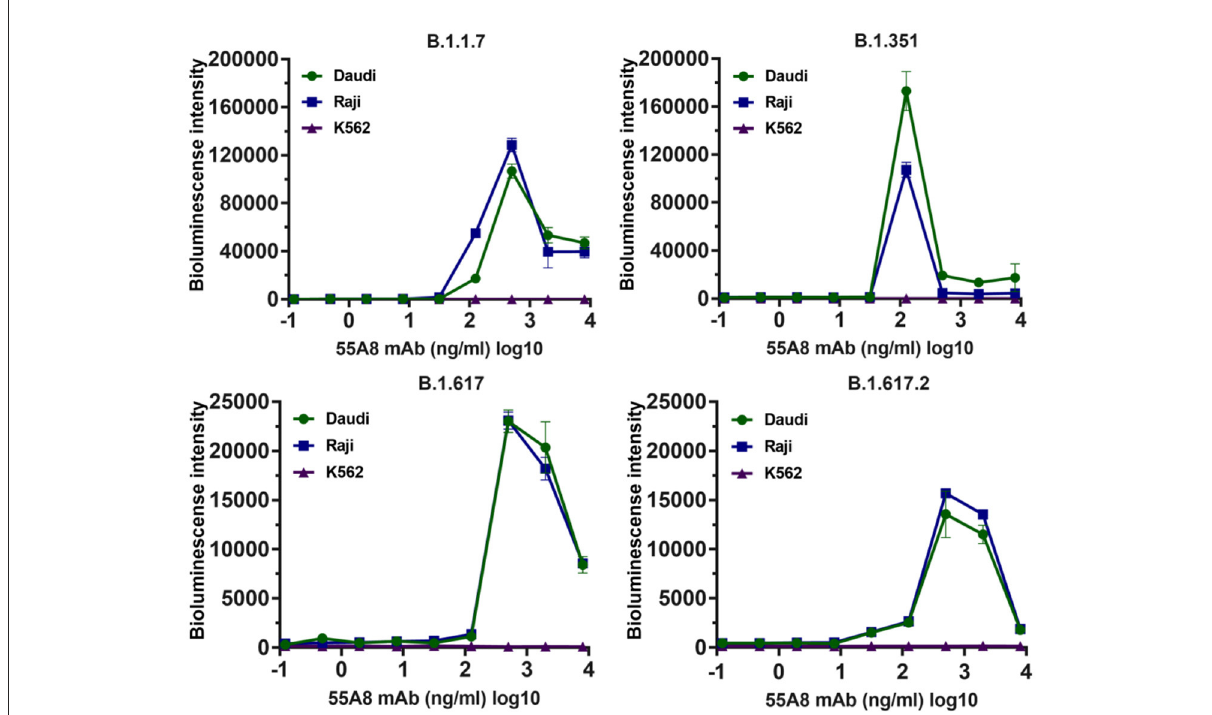
FIGURE4 The ADE activities of 55A8 for the newly emerged variants. New epidemic SARS-CoV-2 variants (including B.1.1.7, B.1.351, B.1.617, and B.1.617.2) were preincubated with serially 55A8, and their mixtures were added to Daudi, Raji, and K562 cells to evaluate their ability to enhance infection. RLU values resulting from infection with variant pseudotyped viruses were quantified by a luminescence meter. Data for each NAb were obtained from a representative infectivity experiment of three replicates and presented as the mean values ±